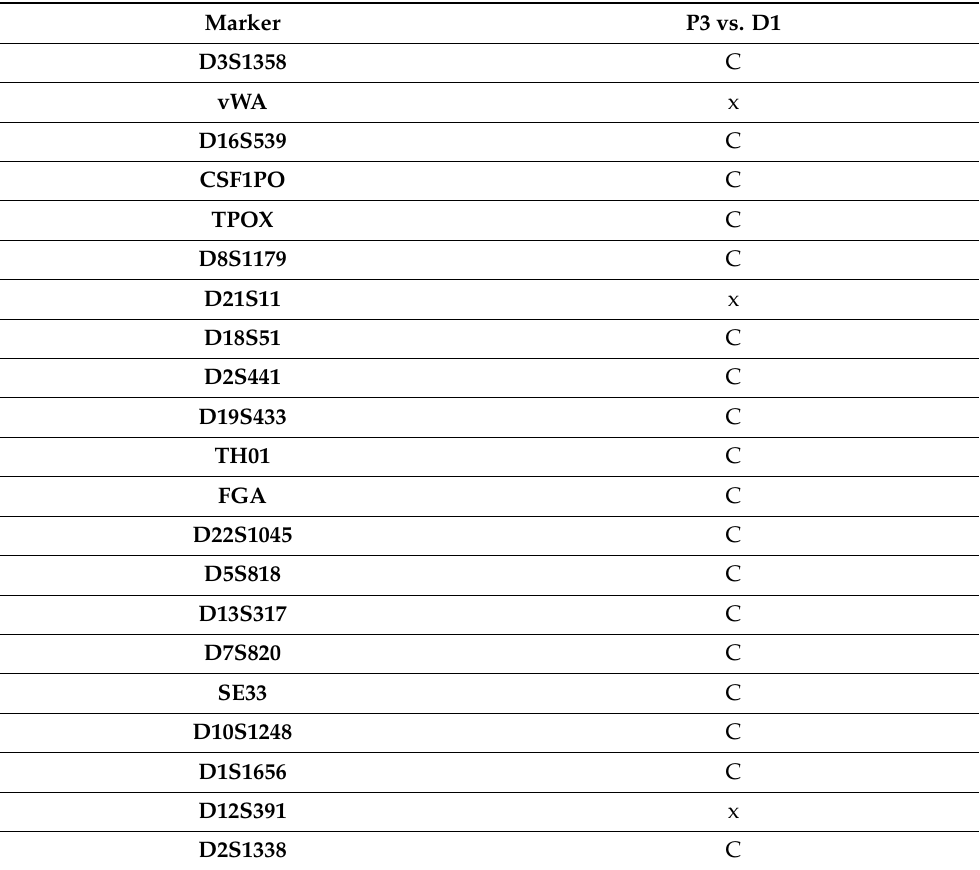
Table 3. Results of the allelic concordance study in autosomal STR markers between John Doe male and John Dusza’s